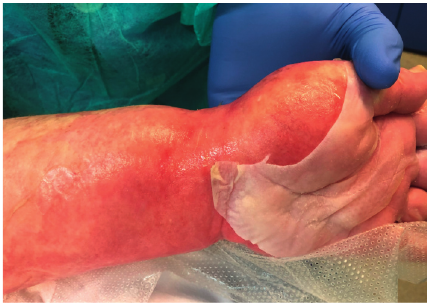
Figure 1: Toxic epidermal necrolysis (TEN): detachment of the top layer of skin of the upper